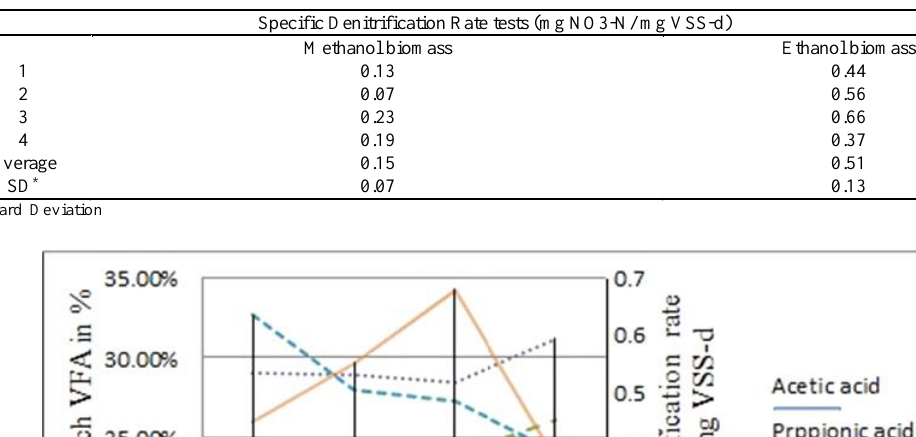
Table 5: Results of the specific denitrification rate tests